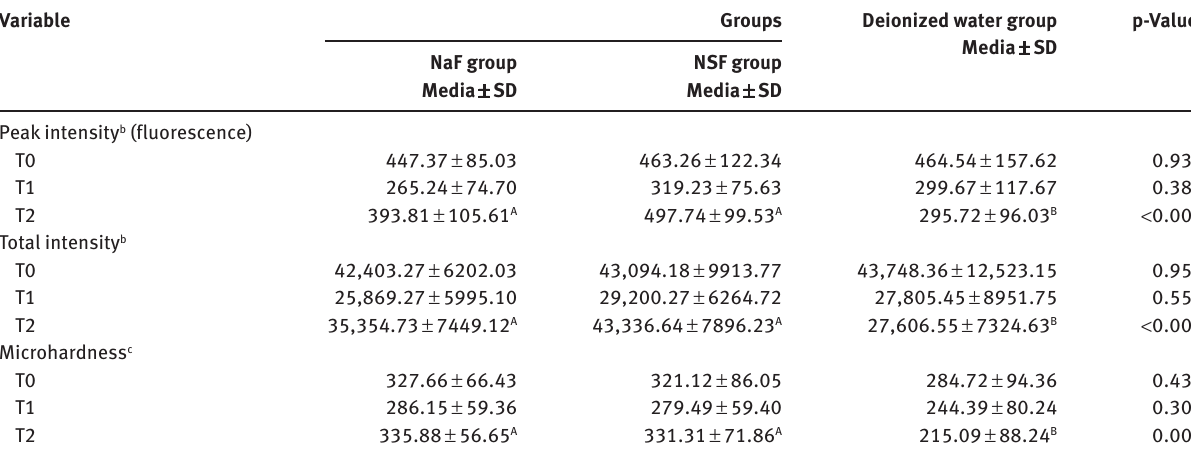
Table 3: Description of the enamel remineralization performance (media ± SD) of each group through the microhardness test and fluorescence spectroscopy at T0, T1 and T2.